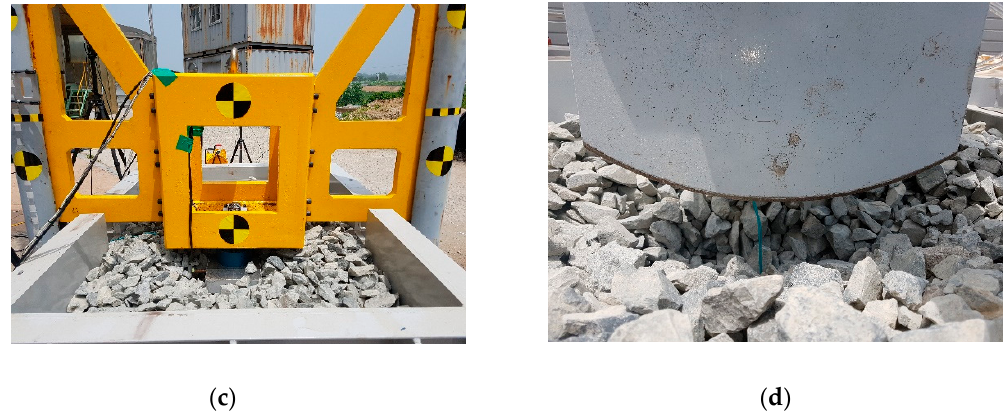
Figure 8. Drop test to simulate the collision between the dropped weight and gravel layer: ( a ) Front view of the drop test; ( b ) gravel layer; ( c ) weight penetration; ( d ) gravel layer after penetration.